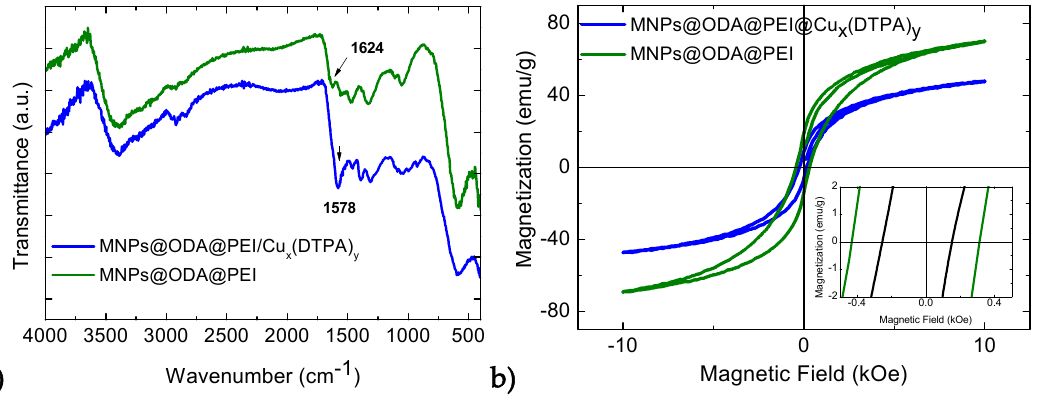
Figure 9. (a) FT-IR spectra of the nanoparticles with (blue line) and without (green line) the presence of the complex and (b) the hysteresis loops of the MNPs before and after the functionalization with the complex.